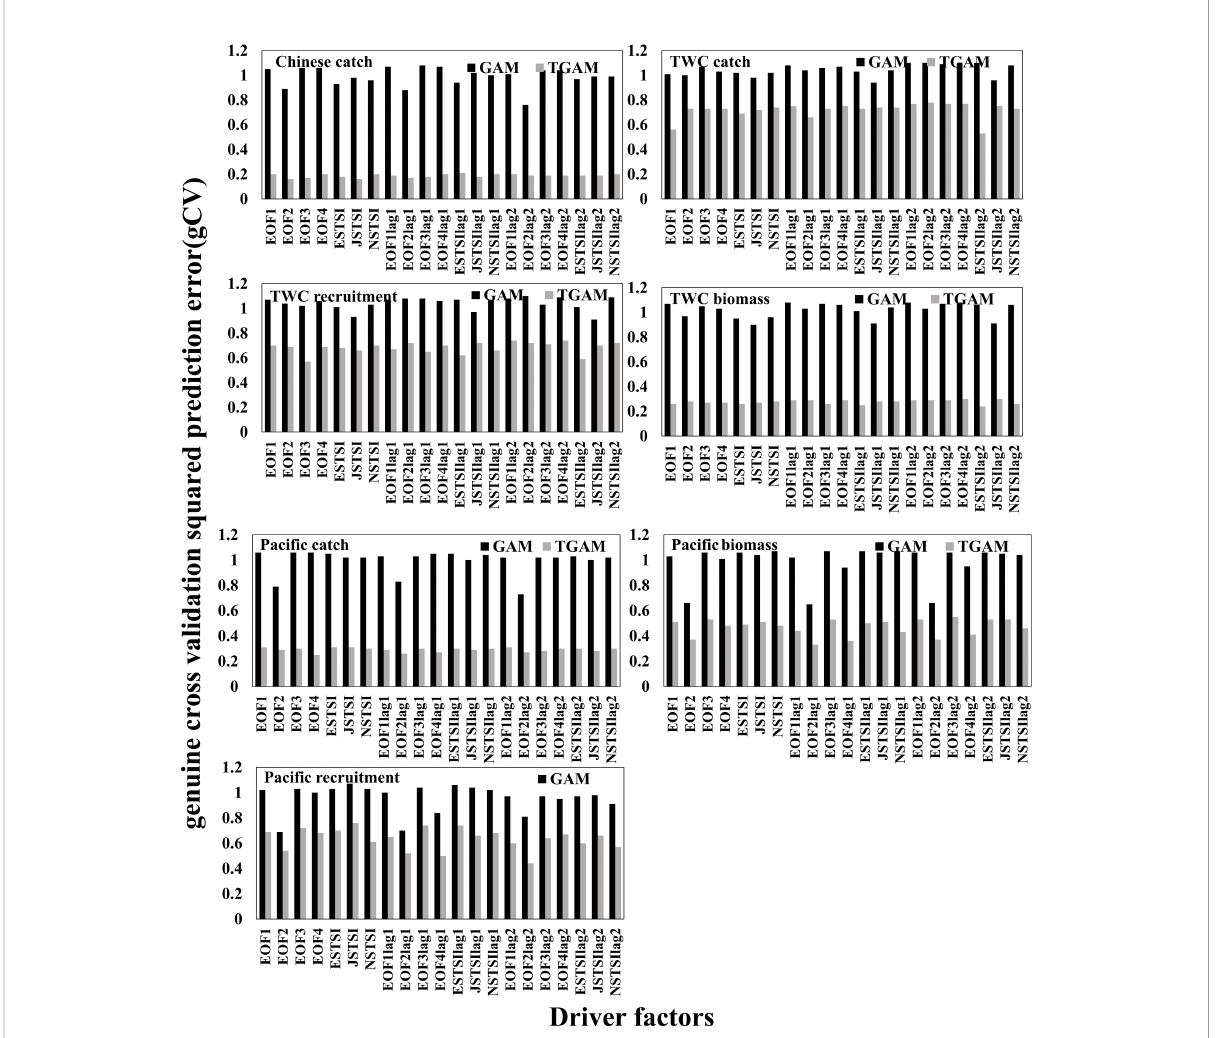
FIGURE 6 Model comparisons between stationary and non-stationary models. Black bars show the “ genuine ” cross-validation squared prediction error (gCV) of stationary models (GAMs) and gray bars show the gCV of non-stationary models (TGAMs). Suf fi xes lag1 and lag2 represent time lags of 1 and 2 years,